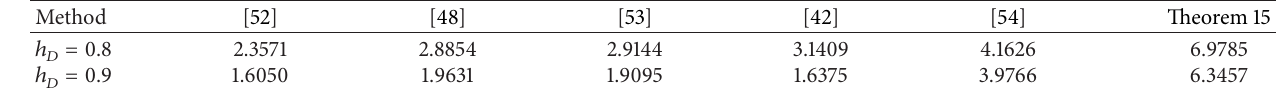
Table 7: Maximum allowable time-delay bounds ℎ for different values ℎ 𝐷 in Case C.